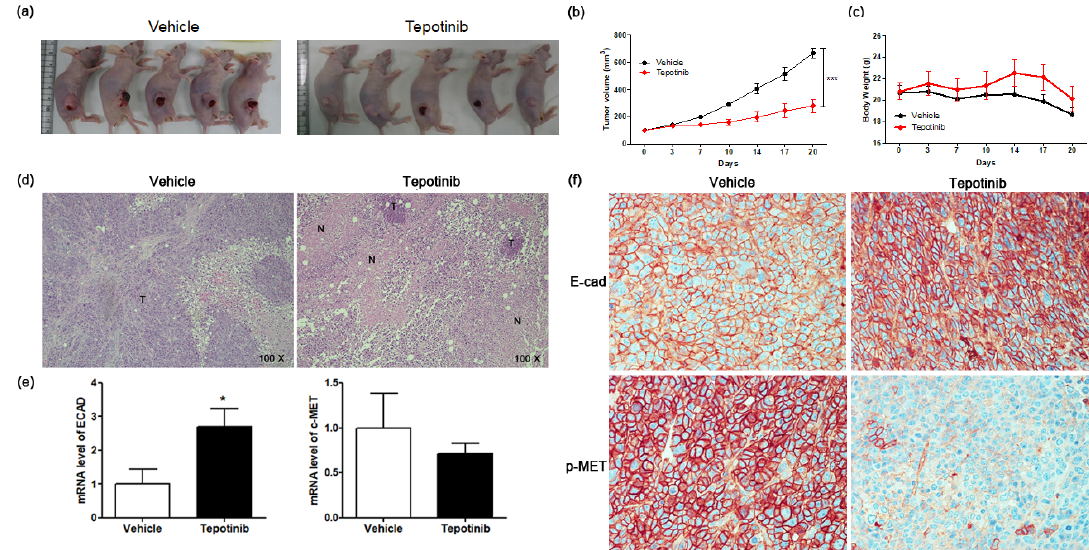
Figure 6. The effect of tepotinib on MKN45 xenograft tumor growth in nude mice. ( a ) Reduced xenograft tumor size by tepotinib treatment. ( b ) Volume (mm 3 ) of the MKN45 xenograft tumors, measured twice per week. Significance was evaluated by two-way ANOVA; *** P < 0.001 compared with the vehicle-treated control. ( c ) Change in body weight ( g ) in a xenograft mouse. ( d ) Histological analysis of xenograft tumors in the presence versus absence of tepotinib treatment (magnification ×100). Untreated control xenografts had differentiated carcinoma cells without necrosis. A tepotinib-treated xenograft tumor showed increased scattered necrotic lesions. ( e ) mRNA levels of ECAD and c-MET in a xenograft mouse were determined by quantitative reverse-transcription polymerase chain reaction. Data are means ± standard deviation. Significant differences were evaluated by t-test; * P < 0.05. ( f ) Immunohistochemical analysis of ECAD and p-MET in the MKN45 tumor sections treatment (magnification ×400).